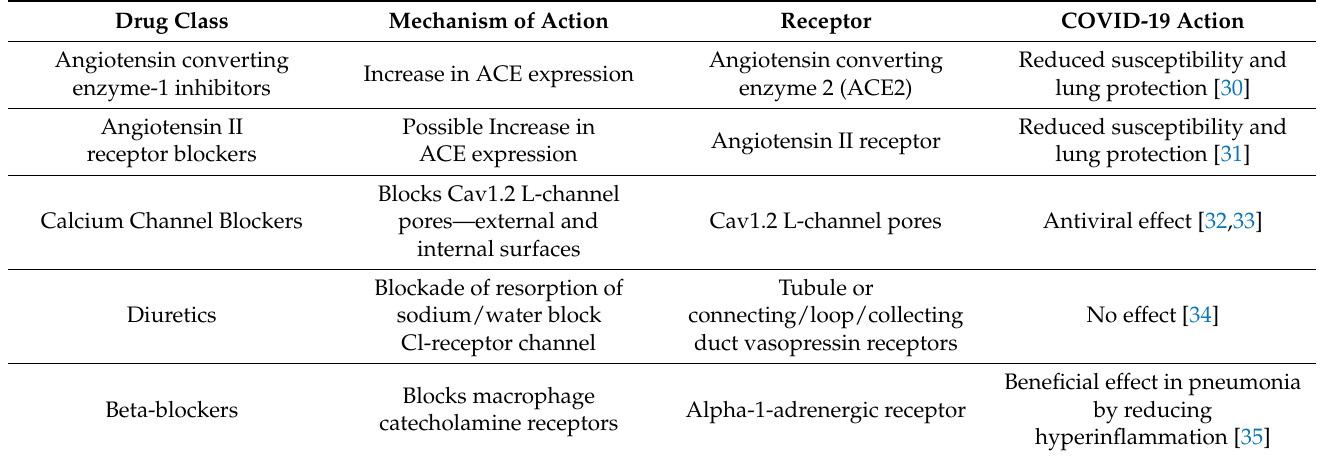
Table 5. Medication and Effects on the SARS-CoV-2